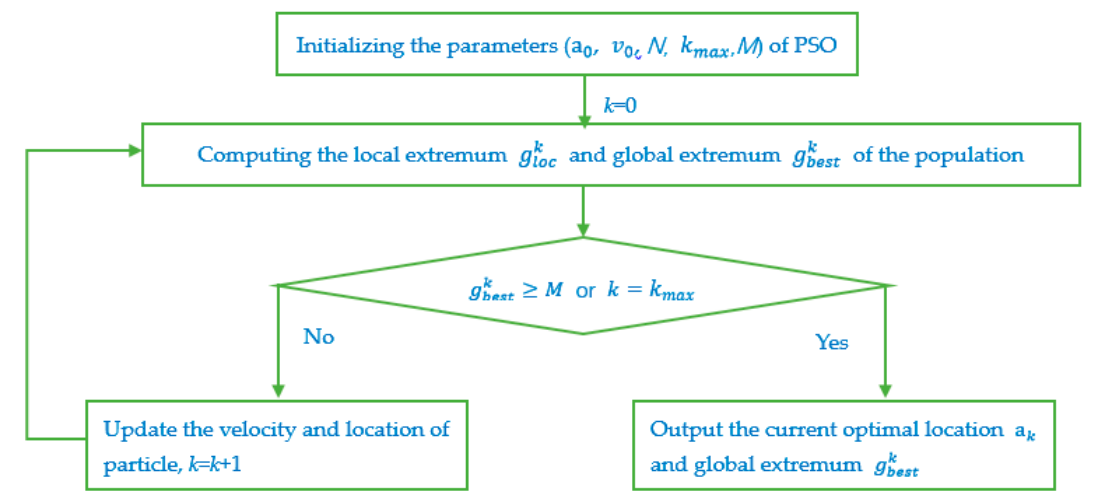
Figure 5. Flow chat of solving the optimal model with Particle Swarm Optimization (PSO) algorithm.